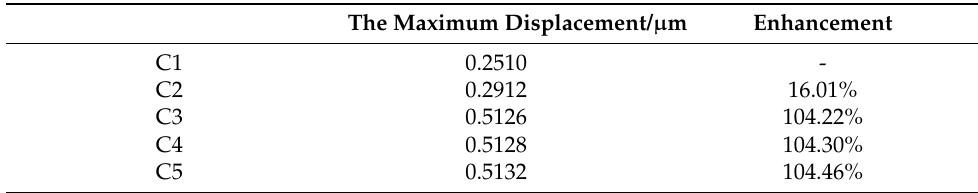
Figure 11. Displacement curves of C1–C5. Table 6. The maximum displacement and enhancement of C1–C5.